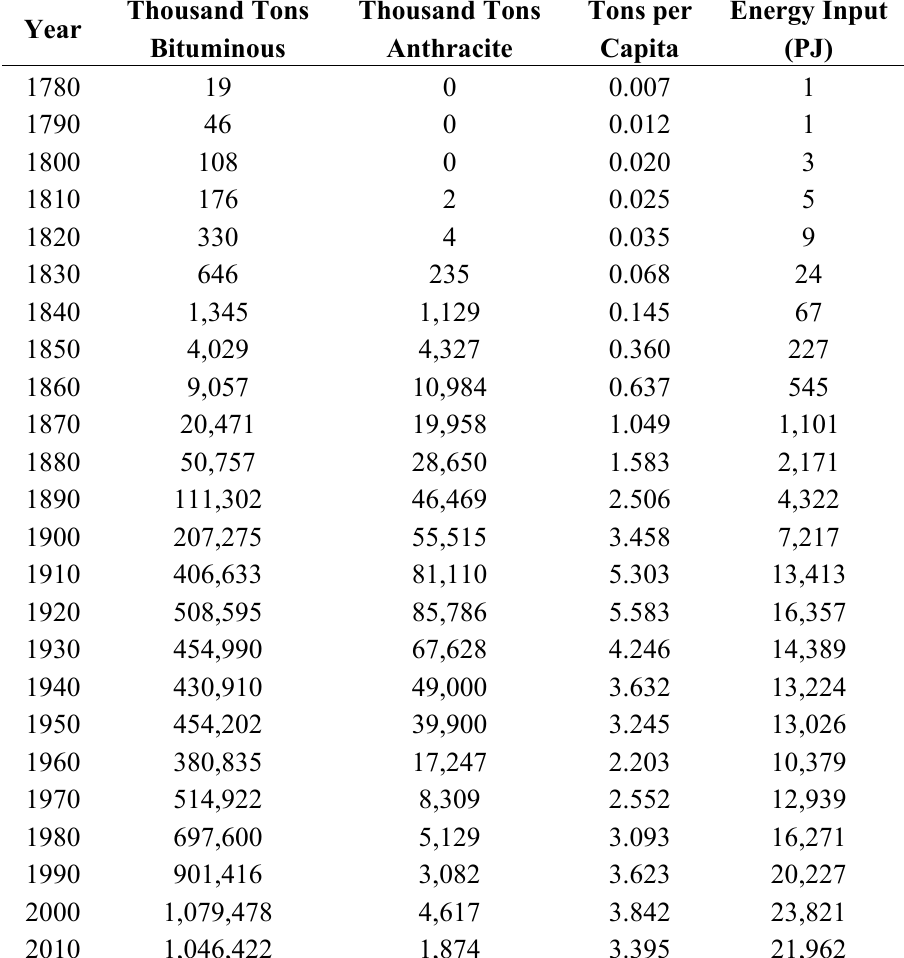
Table 4. Coal consumption in the United States, 1780–2010. Sources: [6] for 1800–1900; [1] for 1910–1950; [25] for 1960–2010. Consumption for 1780 and 1790 estimated using a 9% annual growth rate to reach 1800